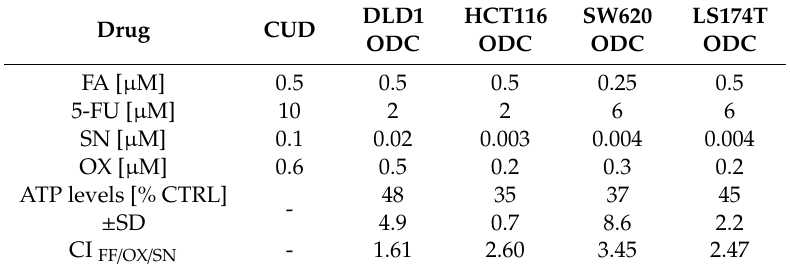
Table 3. E ffi cacy and combinatory index (CI) of four-drug mixtures at CUD and ODC doses. Drug Table 3. Efficacy and combinatory index (CI) of four-drug mixtures at CUD and ODC doses.